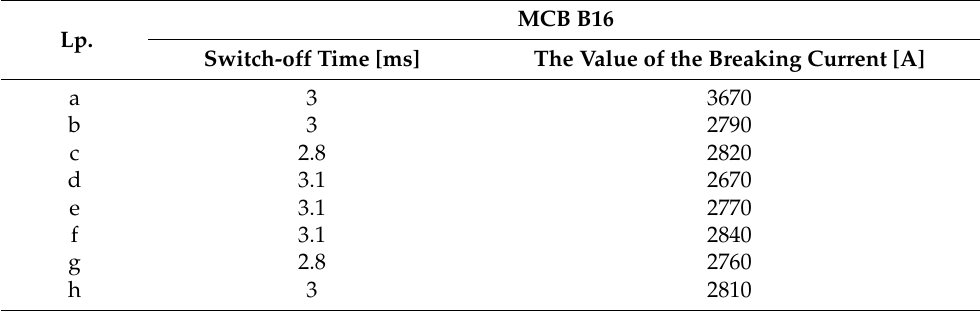
Table 2. Juxtaposition of switching off